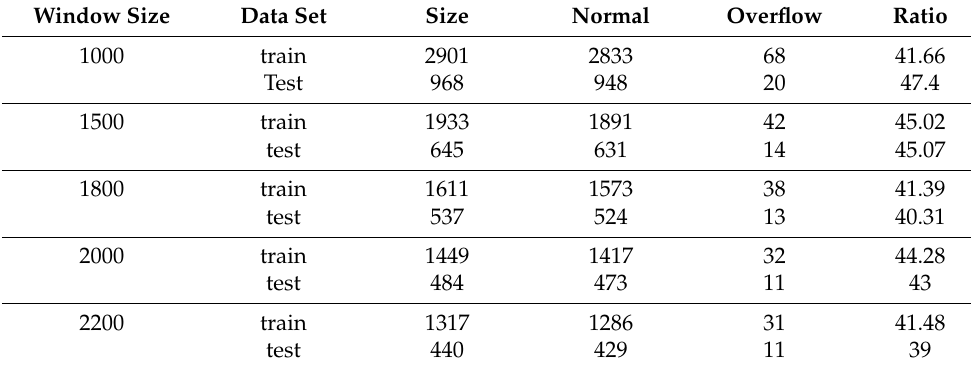
Table 8. Statistic of data set with different sizes of sliding windows.